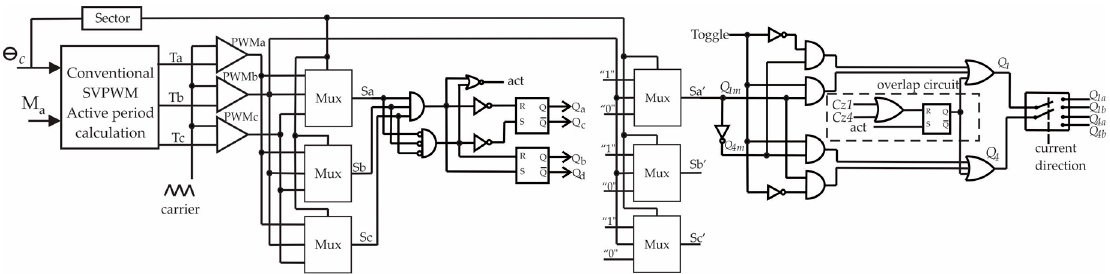
Figure 6. Block diagram to generate the switching states for the matrix converter and the H bridge.